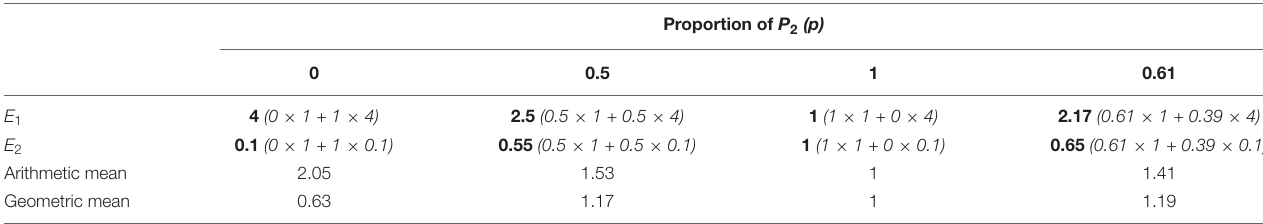
A genotype may invest in two different phenotypes, P 1 and P 2 , with a fixed proportion p. P 1 has four offspring if in environment E 1 , but 0.1 if in E 2 ; P 2 achieves 1 fitness in either environment. We show arithmetic and geometric mean fitness across environments (Environments E 1 and E 2 are chosen with probability 0.5), as well as their calculation